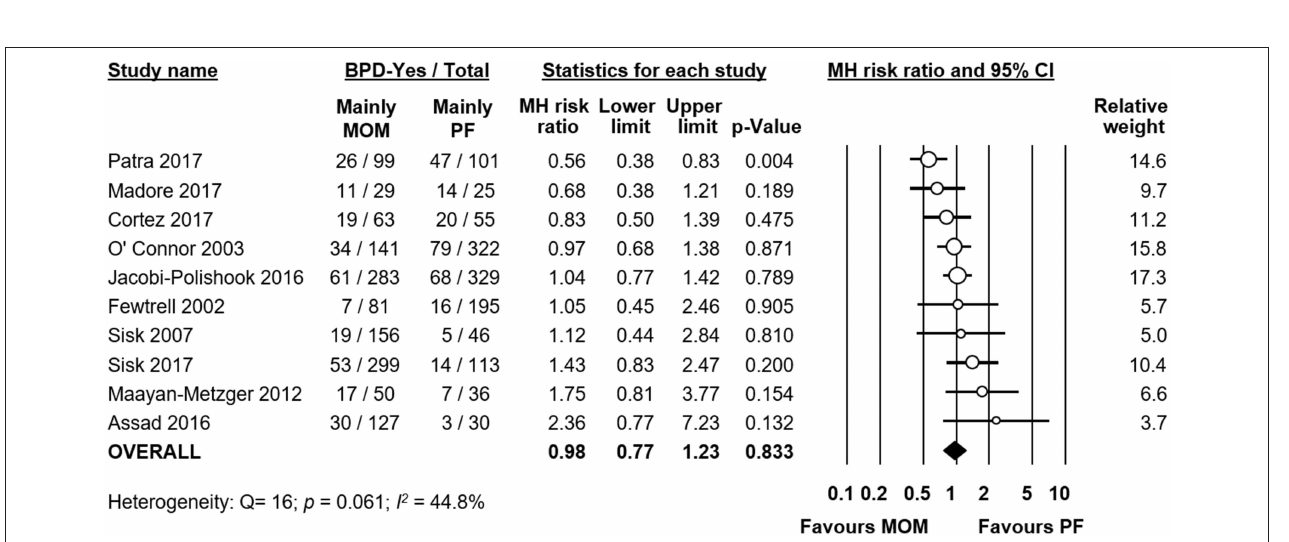
FIGURE 4 | Meta-analysis of mainly MOM vs. mainly PF and risk of BPD. MOM, mother’s own milk; PF, preterm formula; BPD, bronchopulmonary dysplasia; CI, confidence interval; MH, Mantel-Haenszel.